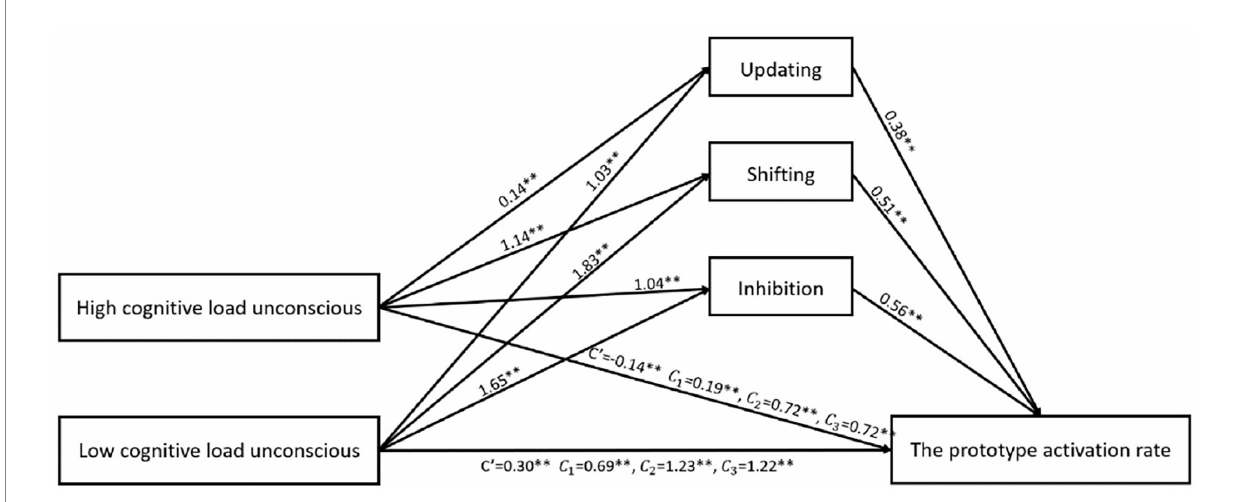
FIGURE 5 Mediation analysis with prototype activation rate as the dependent variable. ** indicates that the correlation is significant at the level of